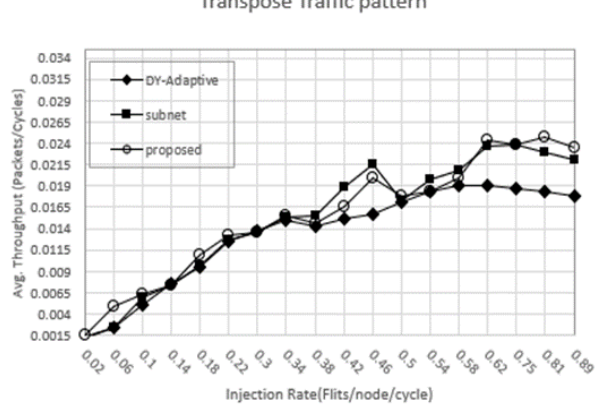
Fig. 14 Average throughput evaluation under synthetic Transpose traffic pattern